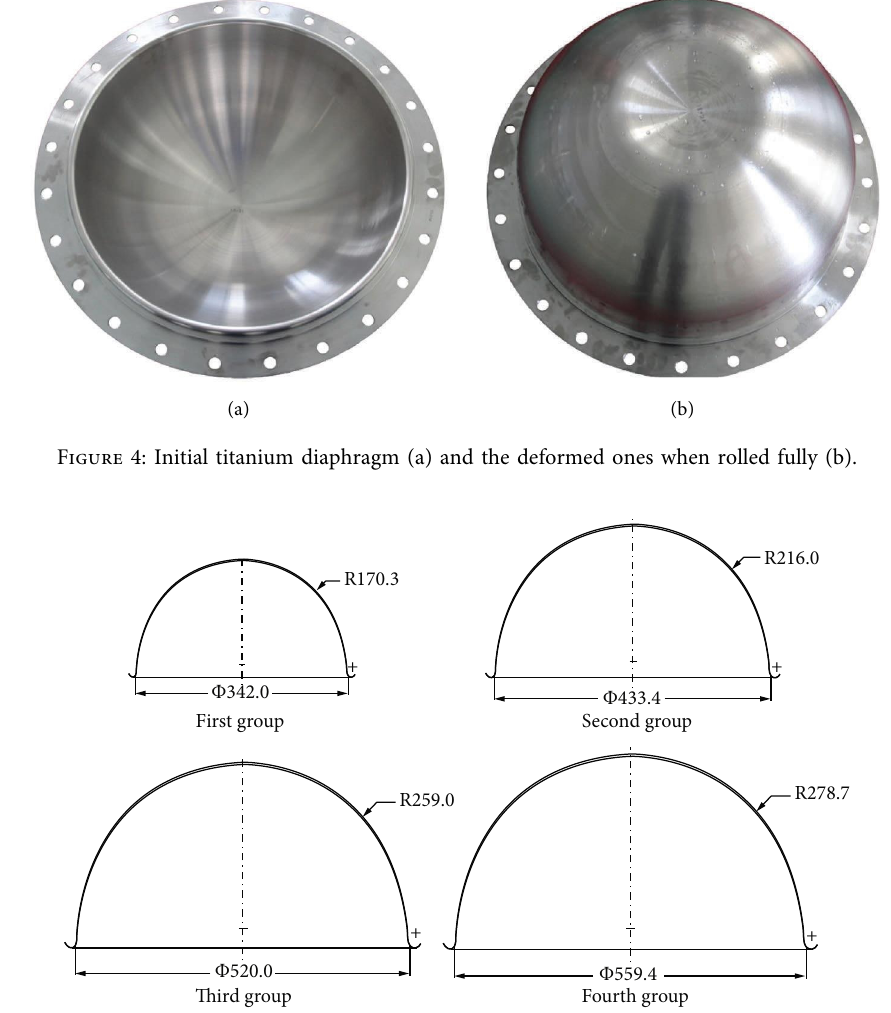
Figure 5: Interior dimensions of titanium diaphragms for every